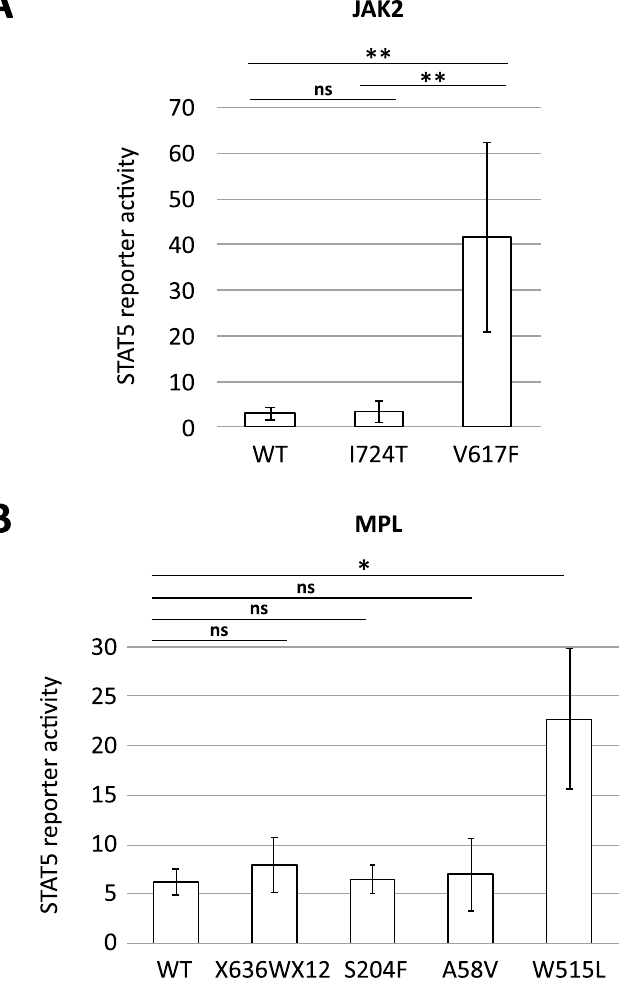
Figure 3. Noncanonical mutants of JAK2 and MPL exhibit wild-type-equivalent levels of STAT5 activation. ( A , B ) STAT5 reporter activity determined by luciferase reporter assay. The y-axis indicates values of STAT5 reporter activity adjusted by the internal control. Plasmids encoding JAK2 ( A ) or MPL ( B ) with the indicated mutation were used. Representative data from multiple experiments are presented. * < 0.05, ** < 0.01, ns: not